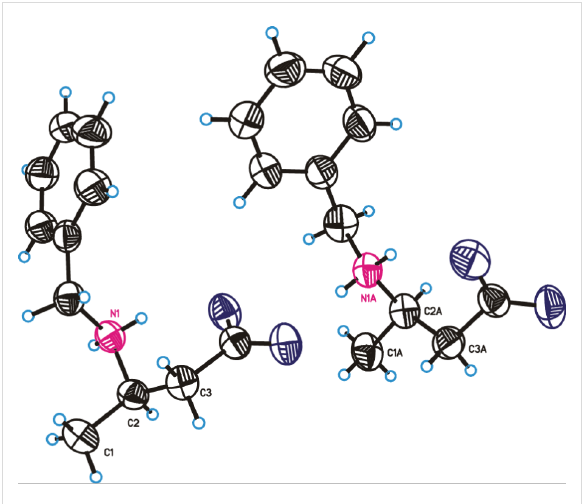
Figure 1: X-ray crystallographic structure of product ( R )- 2a (50% of probability ellipsoids). CCDC registry number